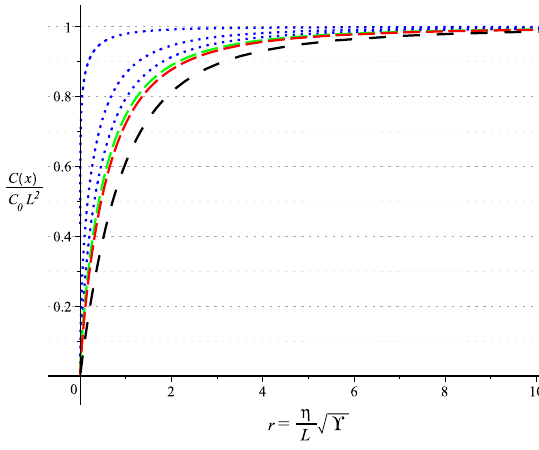
Figure 1 (a). Plot of the c -function as a function of the coordinate x , for the branch x > 1 and ν hairy parameter values ν = 1 . 1 , 1 . 6 , 1 . 9 , 2 . 1 , 2 . 2 , 2 . 7 .